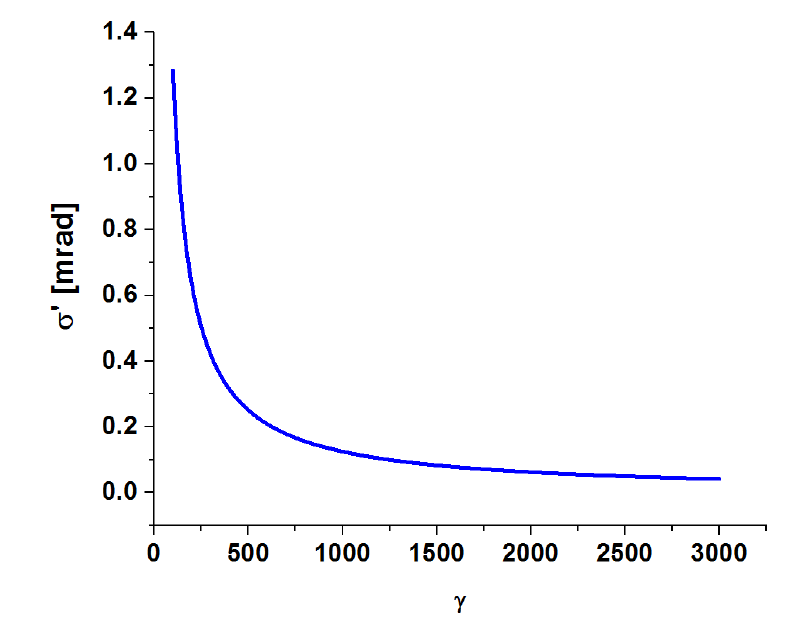
Figure 8. Resolution limit for the beam divergence with respect to the beam energy